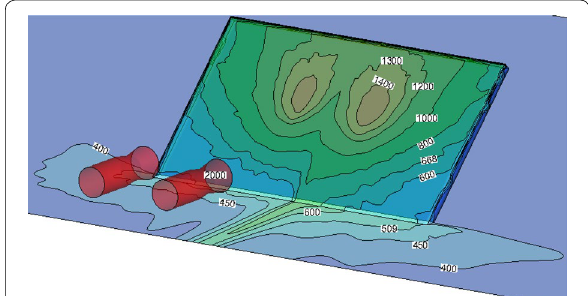
Figure 18 Total temperature contour of the jet blast deflector